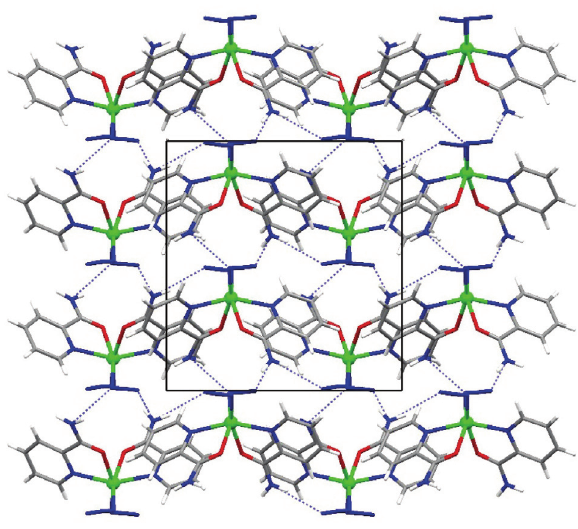
Figure 2b . Crystal packing of 3 viewed down the b axis indicating hydrogen bonding interactions as dashed